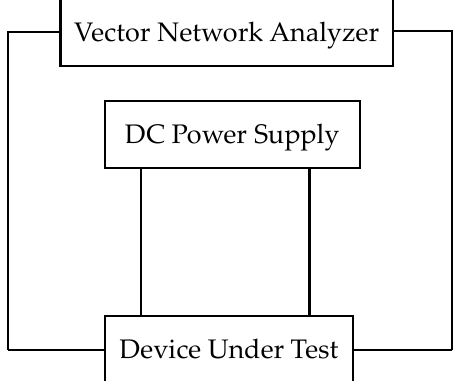
Figure 3. Measurement connections.